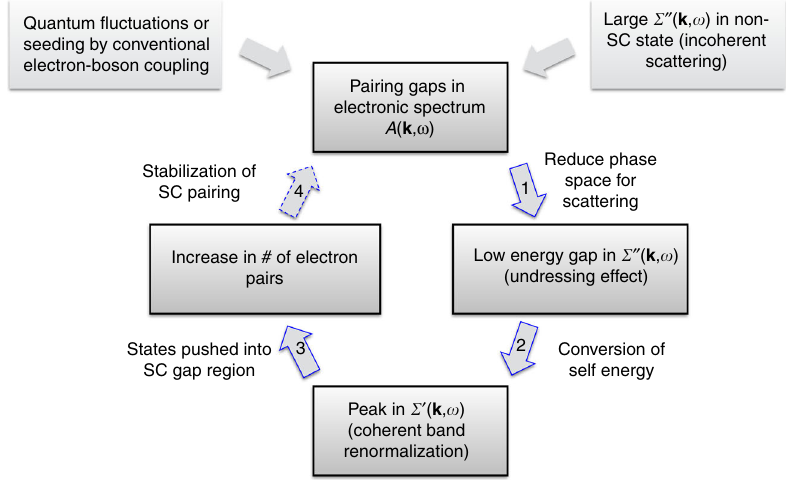
Fig. 5 Proposed positive feedback effect between A ( k , ω ) and Σ ( k , ω ). (1) The onset of pairing fl uctuations (gapping) in the electronic spectrum A ( k , ω ) will start to open a gap in the scattering spectrum Σ ″ because of the removal of the low-energy electronic states. (2) Then as shown in Fig. 4 the gapping and weight transfer in Σ ″ leads to strong peaks in Σ ′ , which give a strong mass enhancement in A ( k , ω ). (3) This low-energy band renormalization brings an increase in the number of low-energy k -states available to participate in the pairing (Fig. 3b, d), i.e., the effect of the pairing on A ( k , ω ) is enhanced by the changes in Σ ( k , ω ). (4) This enhancement in the pairing can feed back to the original pairing fl uctuations of step 1, helping to strengthen and stabilize them. This mechanism is possible because of, or enhanced by, the huge incoherent scattering rate Σ ″ present in the strange-metal incoherent normal